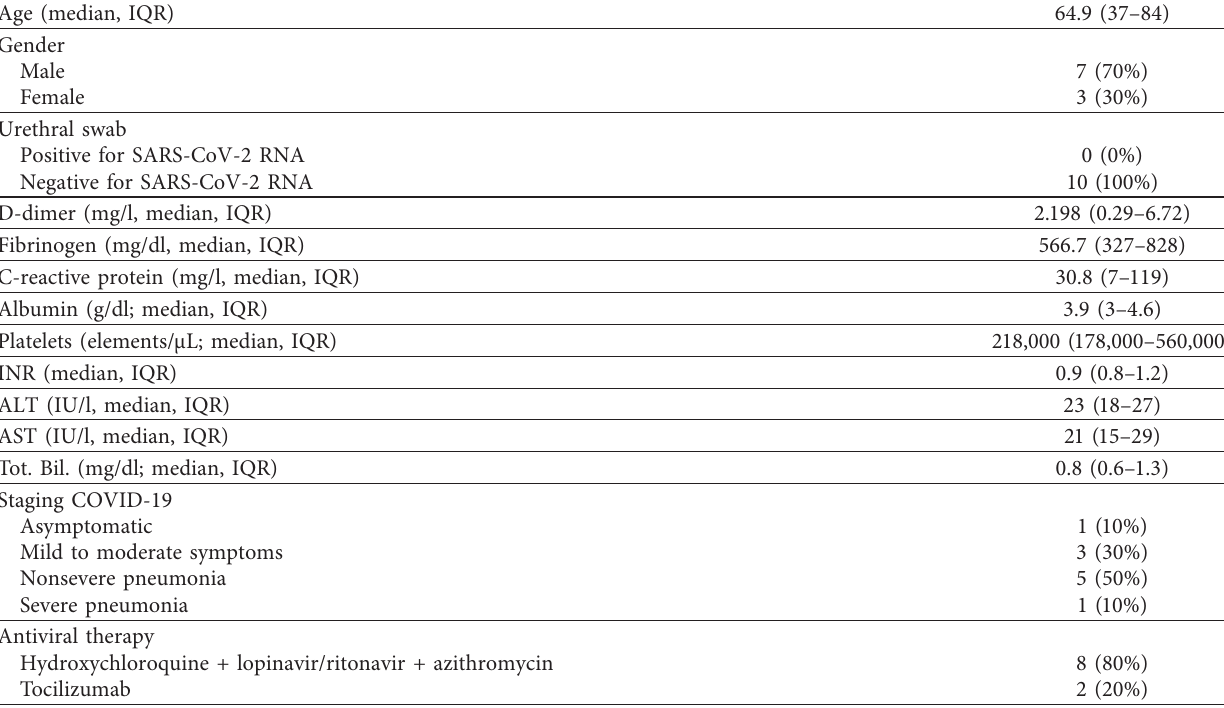
Table 1: Anagraphic clinical features of enrolled